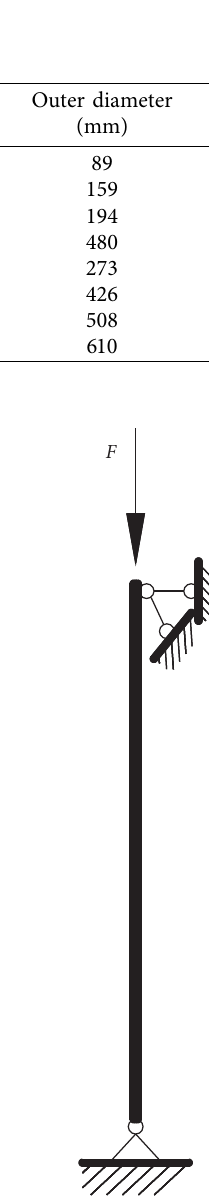
Figure 1: Specimen boundary